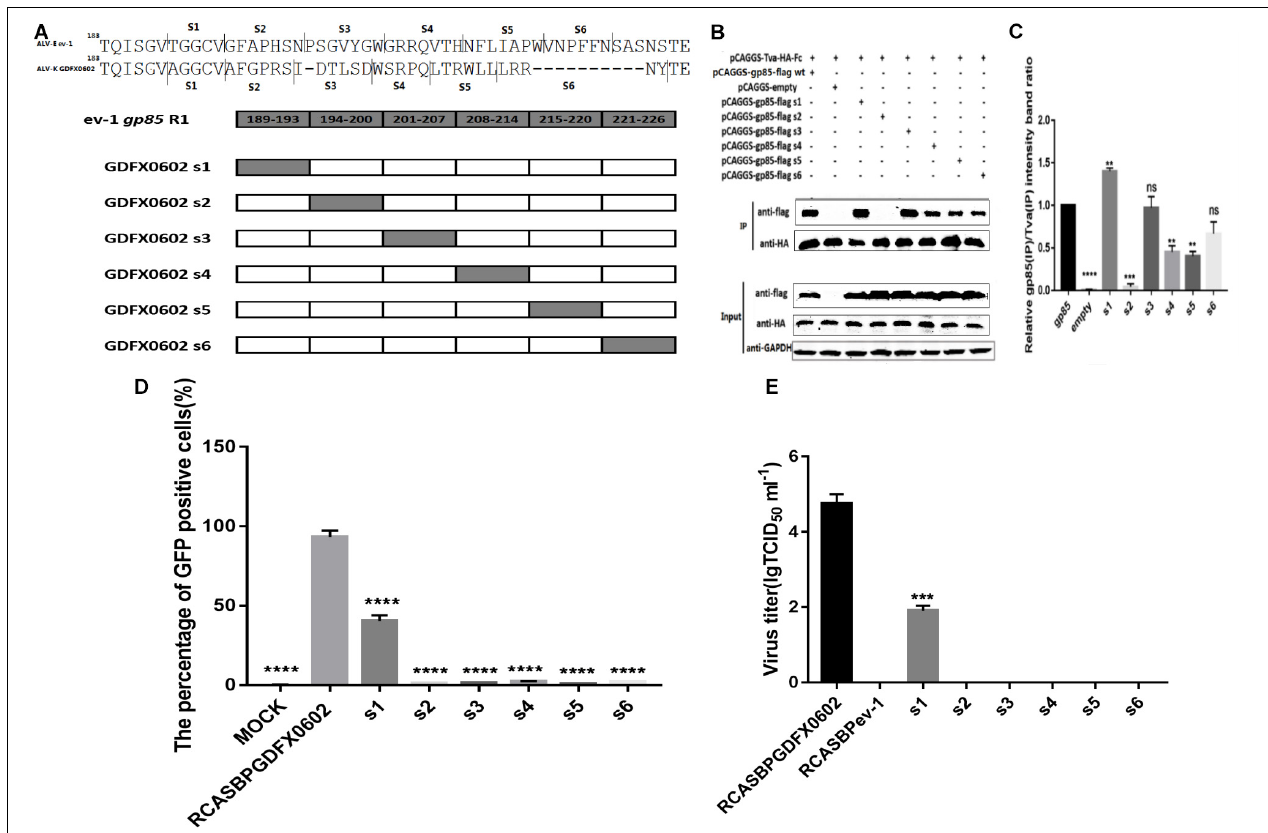
FIGURE 4 | Residues 194–199 and 206–216 in hr1of ALV-K gp85 were the key residues binding to Tva. (A) The relationship between residues R1 (aa189–221) and s1–s6. (B) The interaction of soluble chimeric proteins gp85-flag s1–s6 with Tva-HA-Fc. (C) The level of protein was quantified using Image StudioLiteVer 5.2, and soluble chimeric proteins gp85-flag (IP)/Tva-HA-Fc (IP) were calculated. (D) DF-1 cells transfected with recombinant plasmids RCASBPGDFX0602 s1–s6-EGFP were detected for the percentage of GFP-positive cells by fluorescence-activated cell sorting. (E) The supernatant was collected and diluted in gradient to determine the virus titers. Three independent experiments were performed, and data are shown as mean ± SD in triplicate from a representative experiment. Statistical analysis (two-way analysis of variance) was performed using GraphPad Prism 7; ** P < 0.01, *** P < 0.001, **** P < 0.0001.